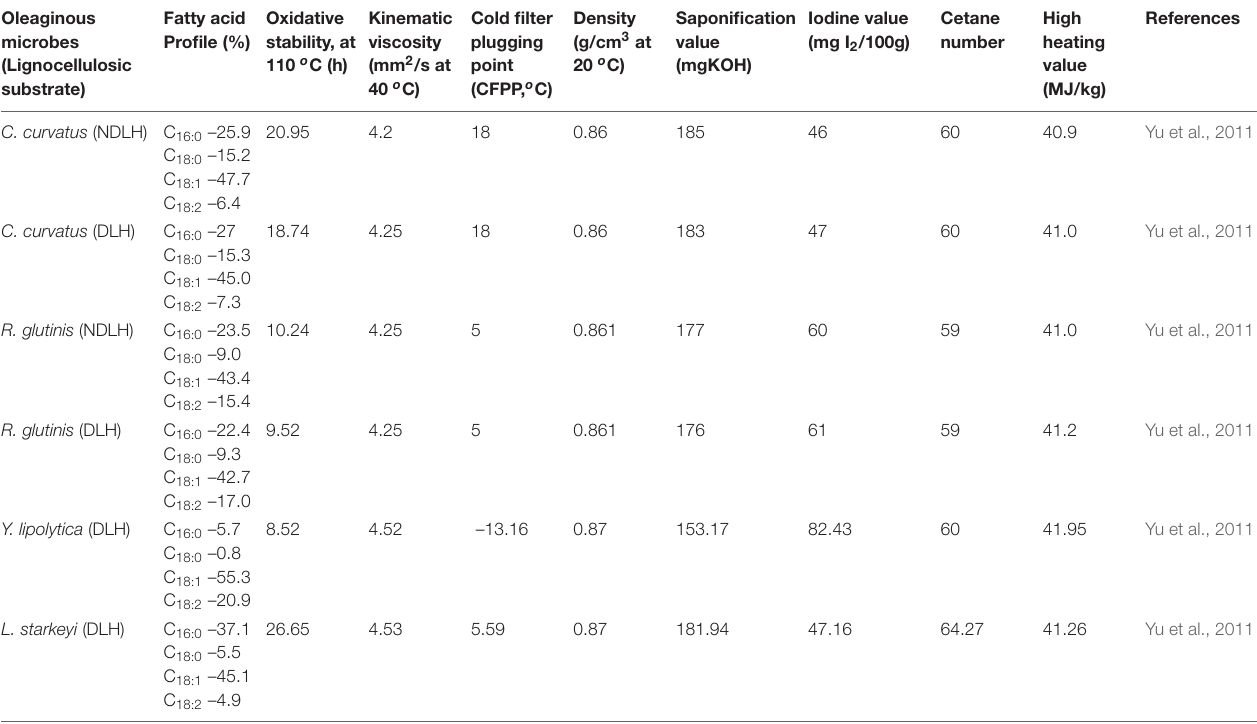
Frontiers in Microbiology |